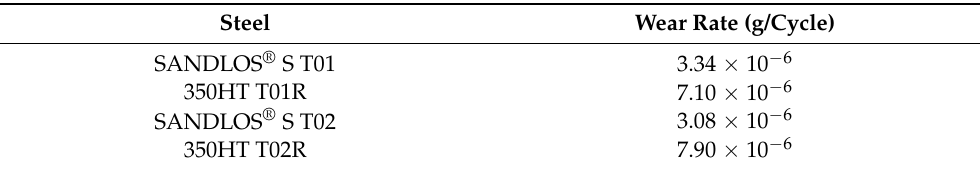
Table 5. Wear rate of the wheel and rail discs during the steady state period of the stepwise training tests.